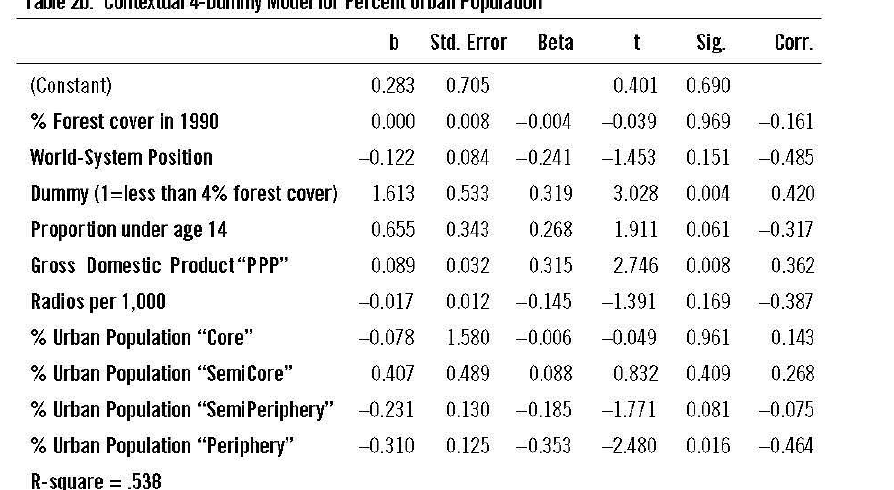
Table 2b. Contextual 4-Dummy Model for Percent Urban